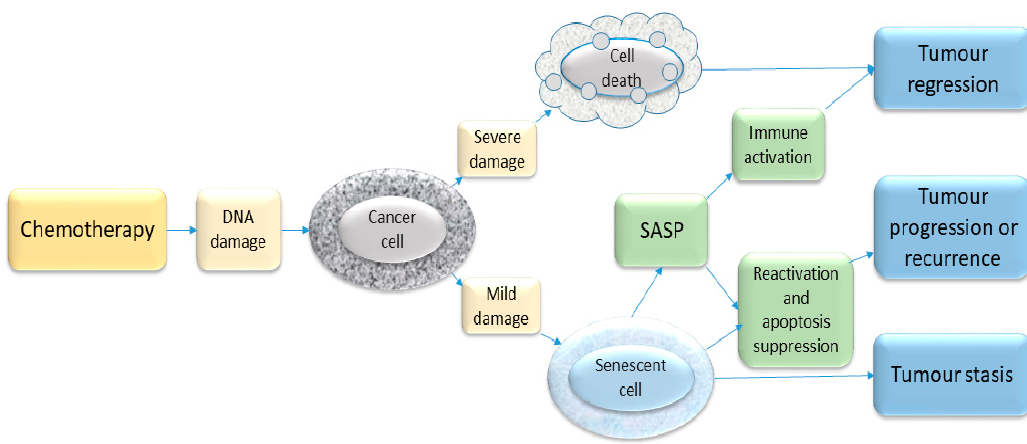
Figure 2. Schematic illustration of some chemotherapy-triggered responses in cancer cells. Most chemotherapeutic drugs induce DNA damage and activate the DDR. If the extent of damage is severe, the cell may die—e.g., through apoptosis. If the damage is sub-lethal, the cell may enter a state of senescence. This senescence response may represent a mechanism of inducing clinical tumour stasis (growth arrest) but in some situations such growth-arrested cells may re-enter the cell cycle and cause disease recurrence. In addition, the release of SASP by senescent cells may contribute to tumour recurrence as well as having an immune stimulatory function. The balance of these various processes will vary, depending on the host tissue and the type and degree of stimuli.